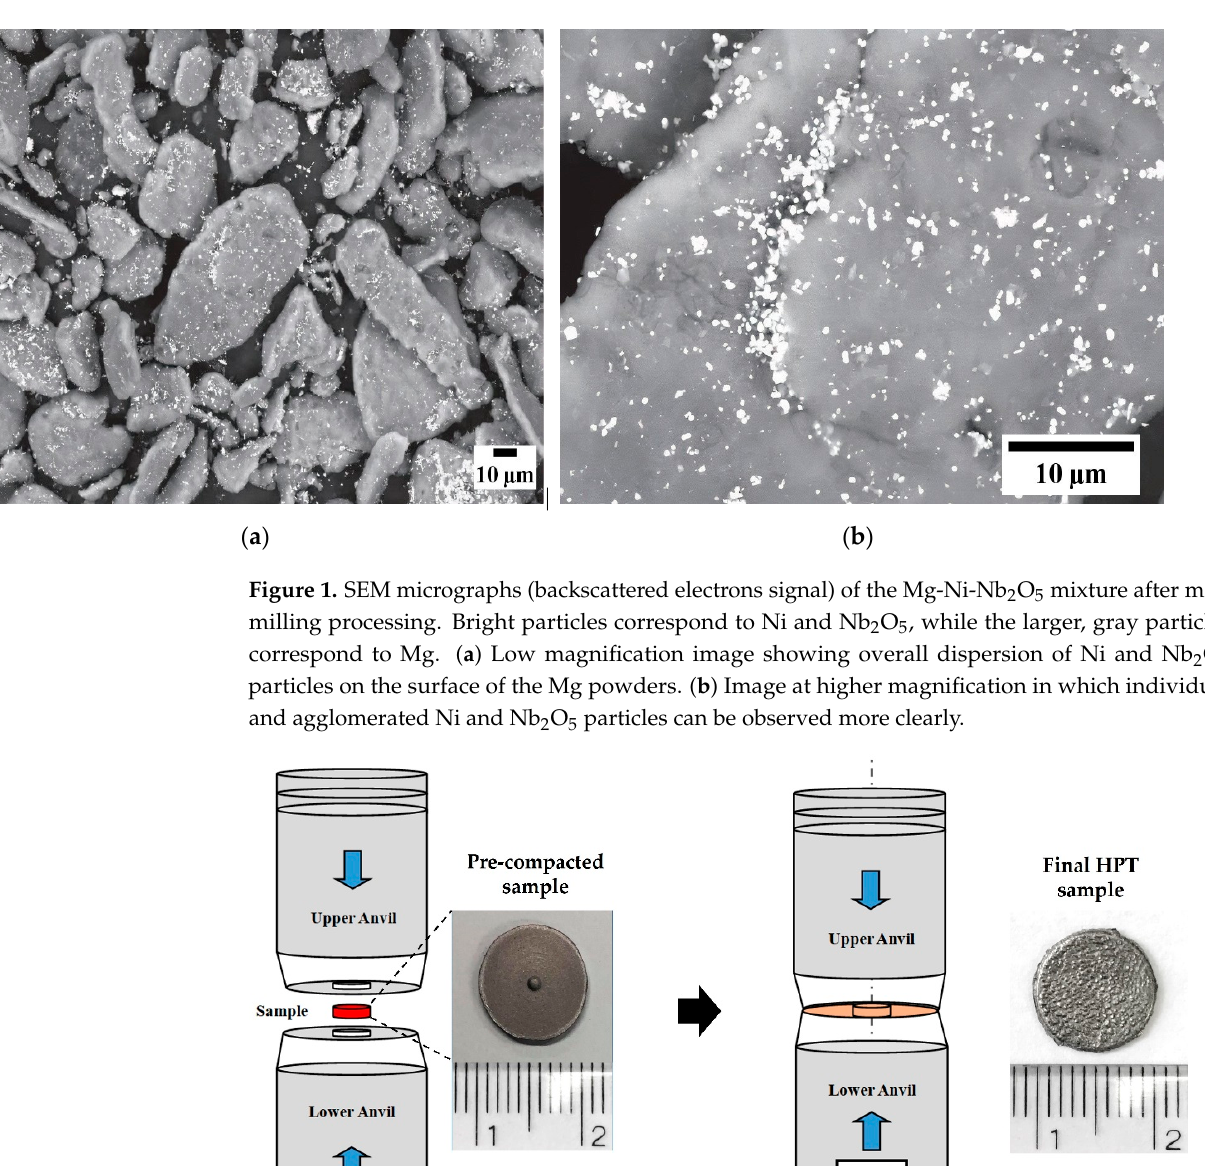
Figure 2. Schematic illustration of a two-step consolidation route employed in this work. ( a ) Uniaxial compression of powder mixture into a pre-compacted disk. ( b ) Deformation using HPT.